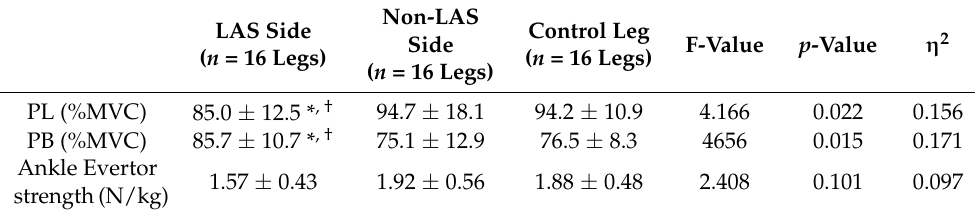
Table 4. PL and PB muscle activities during ankle eversion in the LAS and non-LAS sides and in the control leg. LAS